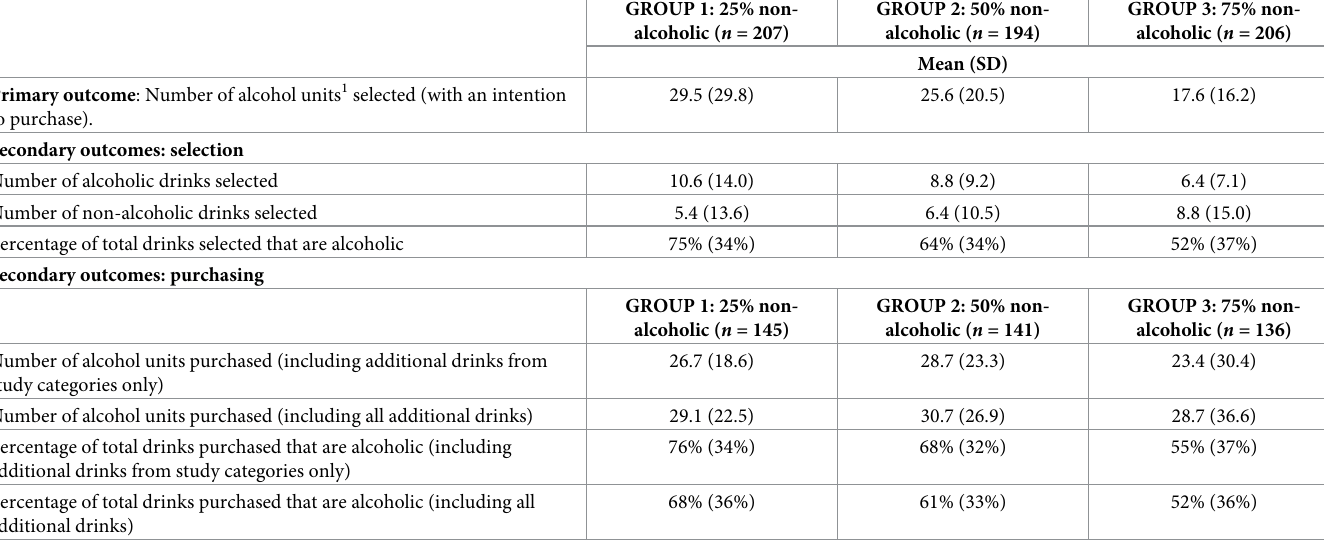
Table 2. Primary and secondary outcomes (raw means